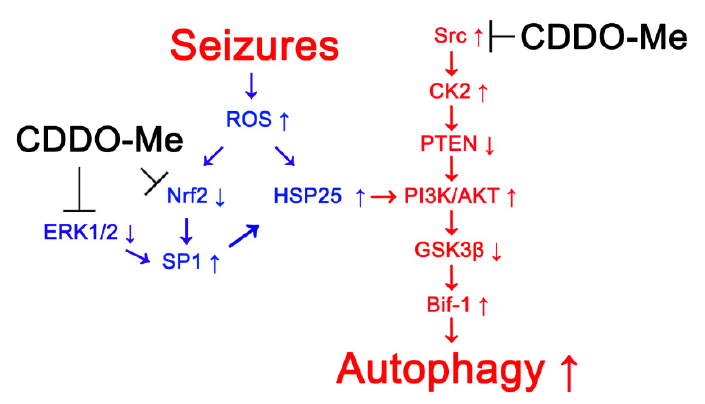
Figure 8. Schematic depiction representing the effects of CDDO-Me on astroglial autophagy (clasmatodendrosis). CDDO-Me activates Nrf2-mediated antioxidant defense mechanisms and SP1 suppression, which inhibit further ROS synthesis and HSP25 induction, respectively. In addition, CDDO-Me facilitates ERK1/2-SP1-mediated HSP25 suppression that abrogates PI3K/AKT acti- vation. CDDO-Me also abolishes the PI3K-AKT-Bif-1 signaling pathway by repressing Src-CK2-mediated PTEN